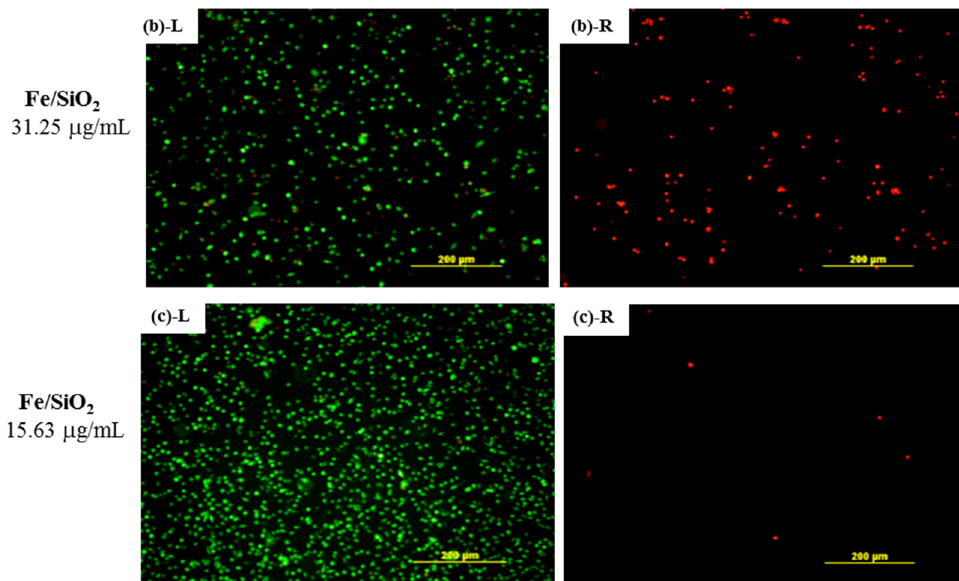
Figure 6. Live/dead stain results of L929 cells cultured with ( a ) medium only as the control and with SiO 2 @Fe/SiO 2 spheres at ( b ) 31.25 μ g/mL and ( c ) 15.63 μ g/mL. (Left column showing the green fluorescence represents live cells; right column with red fluorescence reveals dead cells).